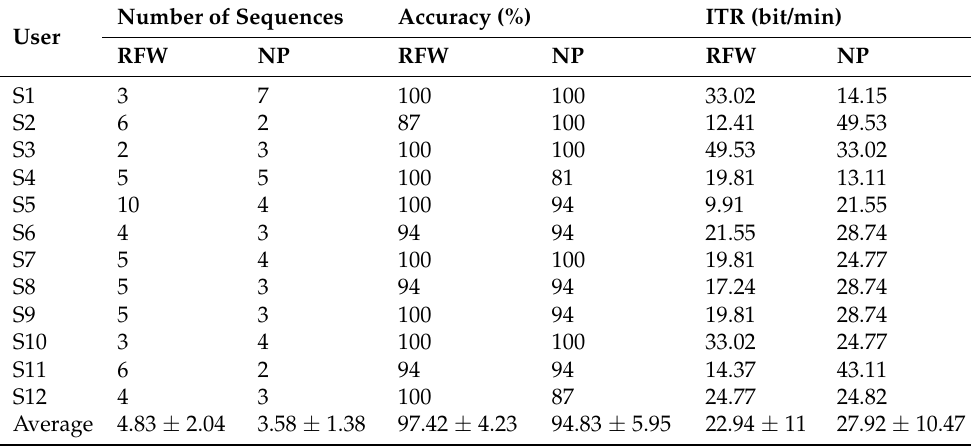
Table 1. Results for each participant, and average ( ± standard deviation), in the copy-spelling phase in terms of number of sequences used, accuracy (%), and ITR (information transfer rate, bit/min) for each condition (red faces surrounded by a white rectangle (RFW) and neutral pictures (NP)).